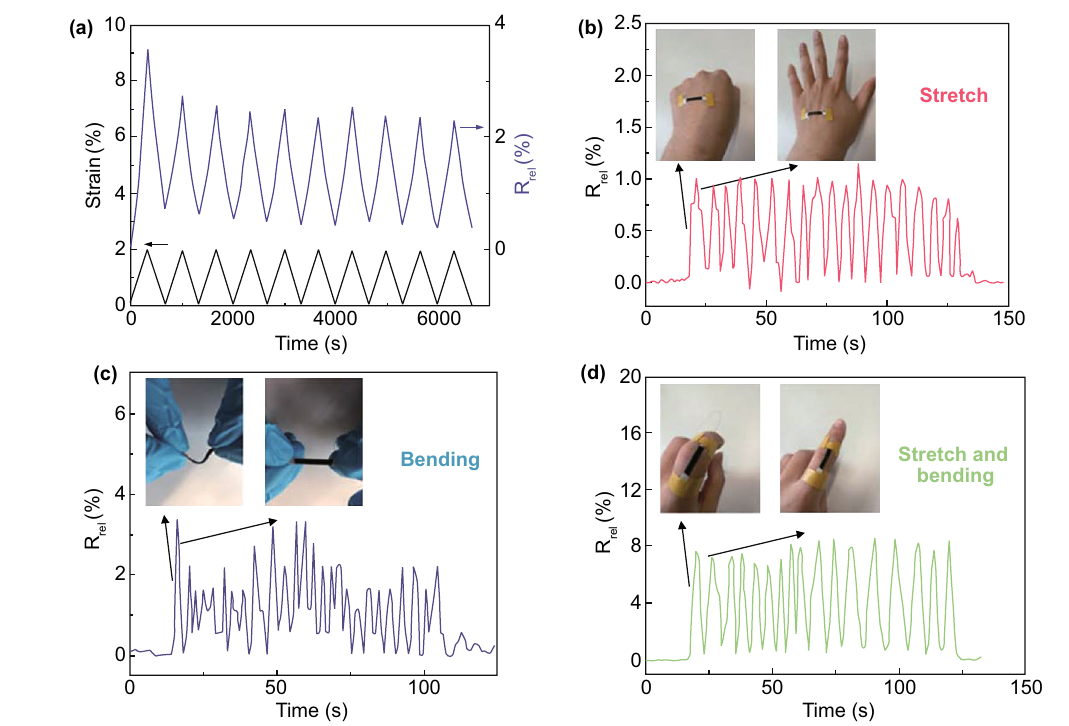
Fig. 23 a NCs-rGO hybrid film electrical resistivity ( R rel ) under fixed cycling stretching strain. b – d NCs-rGO hybrid film electrical resistivity ( R rel ) under stretching-releasing, bending-relaxing, and combined stretching-bending of human hand motion. Reproduced with permission from Ref. [32] Copyright © 2018, The Royal Society of Chemistry